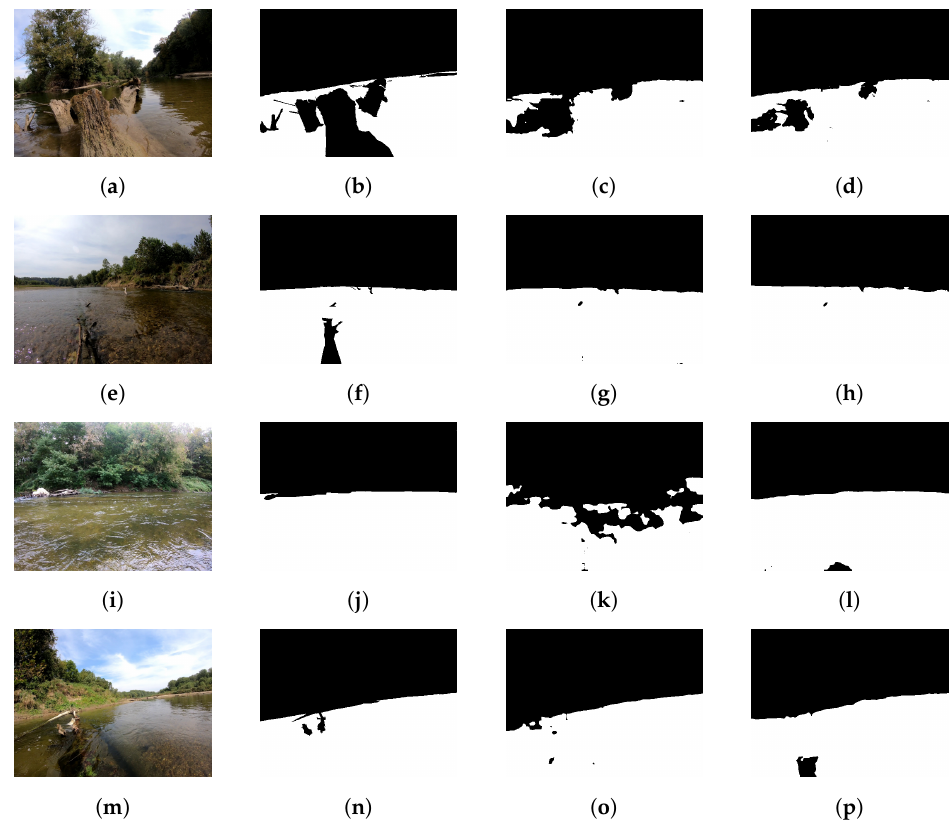
Figure 6. Illustration of network outputs on Sugar Creek scenes after further training on the ROSE- BUD Wabash River image subset [38]. Images ( a – h ) are WaSR outputs after training 4 epochs on Wabash River images, and ( i – p ) are WODIS_Xcept network outputs after training an additional 20 epochs. Columns from left to right are the test image, the ground truth mask, the output of the network after initial training, and the output of the network after further training on the Wabash River